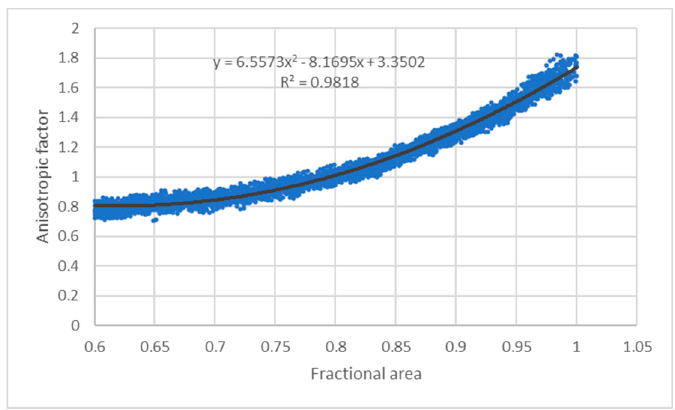
Figure 14. Scatter plot of the global anisotropic factor in the shortwave and fractional area of the sunlit surface in the FOV of Earth–Sun–Moon geometry. A fractional area larger than 0.6 is used